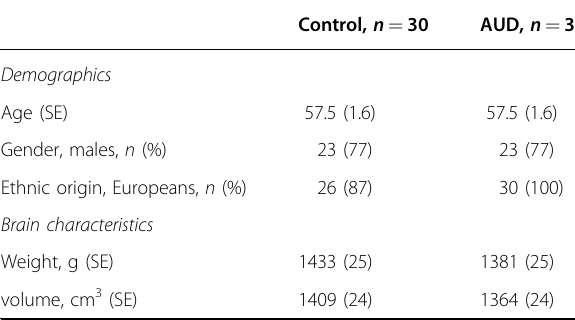
Table 1 Baseline characteristics of patients with alcohol use disorder (AUD) and control